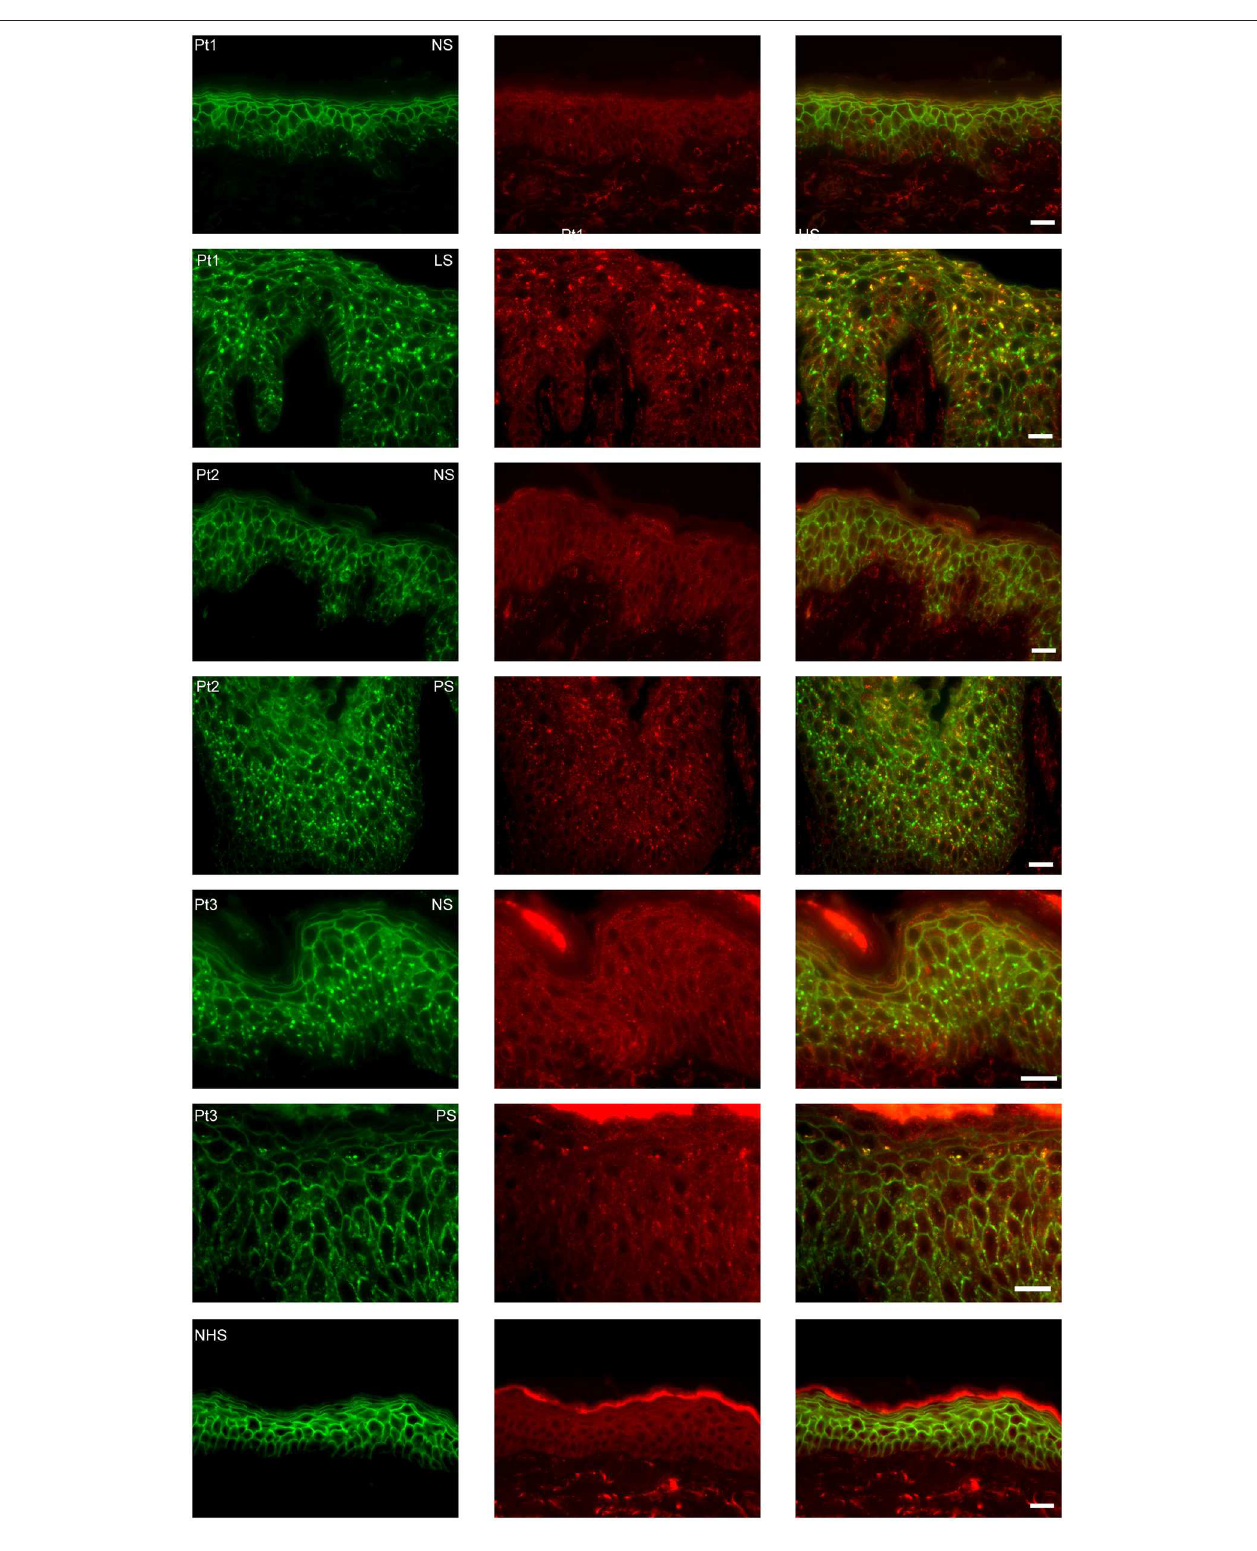
FIGURE 2 | Endocytosis from clusters is not present in non-lesional skin. The images are from three patients of whom we had biopsies of non-lesional skin next to biopsies of perilesional or lesional skin. As control healthy normal human skin is used. In green plakoglobin and in red early endosomal antigen. The panels to the right are overlays. Pt, patient; NS, non-lesional skin; PS, perilesional skin; LS, lesional skin; NHS, normal human skin. White bar is 20 µ m.